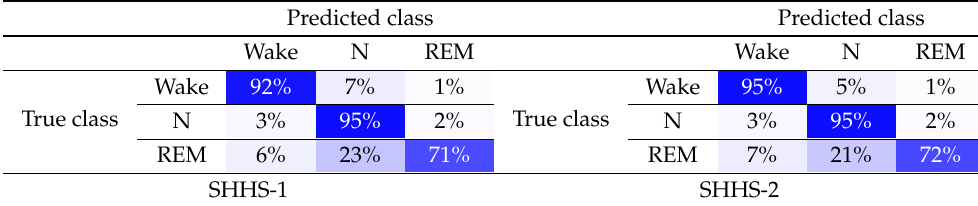
Table 6. Confusion matrix relating to three sleep stages’ classification by using combined signals with 10% hold-out validation.